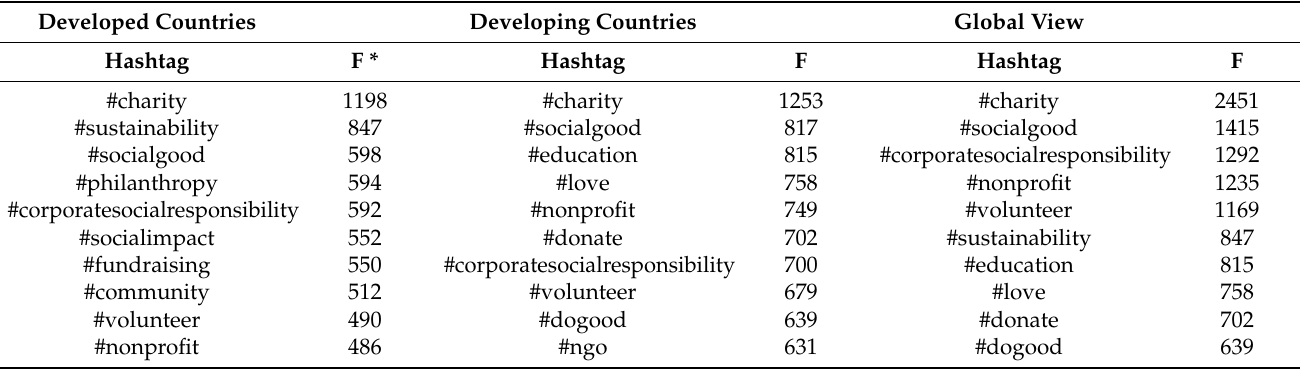
Table 1. Regional differences vs. global